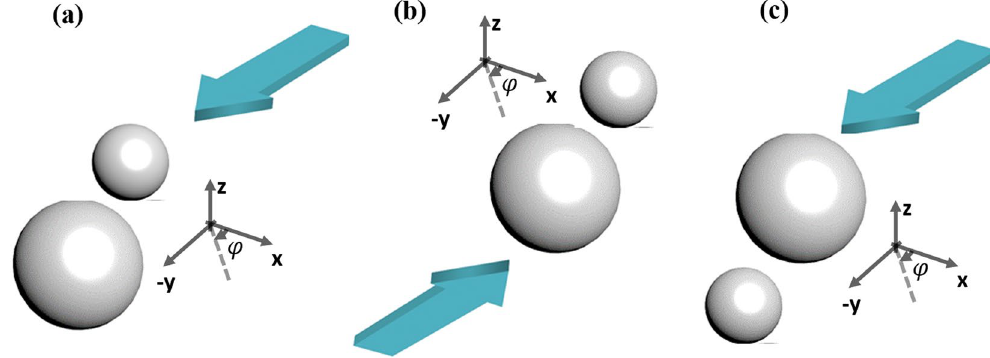
Figure 2. ( a ) The configuration of rotating the bigger object by keeping the smaller object fixed as discussed in previous figure (light is always propagating towards ‘ − y’ direction). At higher wavelength regions, near field binding force is always found repulsive for this configuration after the antibonding resonance mode. ( b ) For the configuration of Fig. ( a ), the change of the direction of propagating light manually by bringing the light source from one side of the dimers to another side (light is propagating towards ‘ + y’ direction). All the times, near field binding force is found attractive when the propagating light is perturbed by the bigger object at first. So, combining ( a ) and ( b ), It will be easily possible to observe the mutual repulsion and attraction of all the heterodimer sets just due to the automatic change of the relative dimer position of smaller and bigger objects at higher wavelength regions after the antibonding resonance mode (discussed in main text before conclusion). ( c ) Another alternative way: by changing the relative orientation of the heterodimers of ( a ) manually (not light propagation direction), it is also possible to observe reversal of binding force at higher wavelength regions after the antibonding resonance